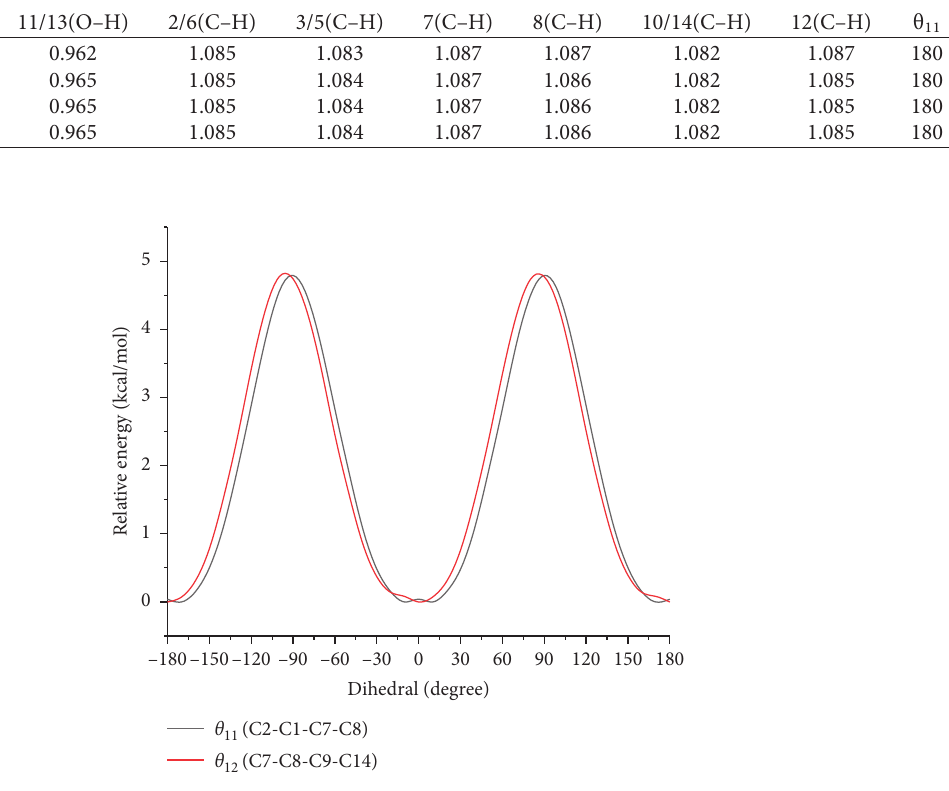
11 (C2–C1–C7–C8) and θ 12 (C7–C8–C9–C14) in the gaseous medium at